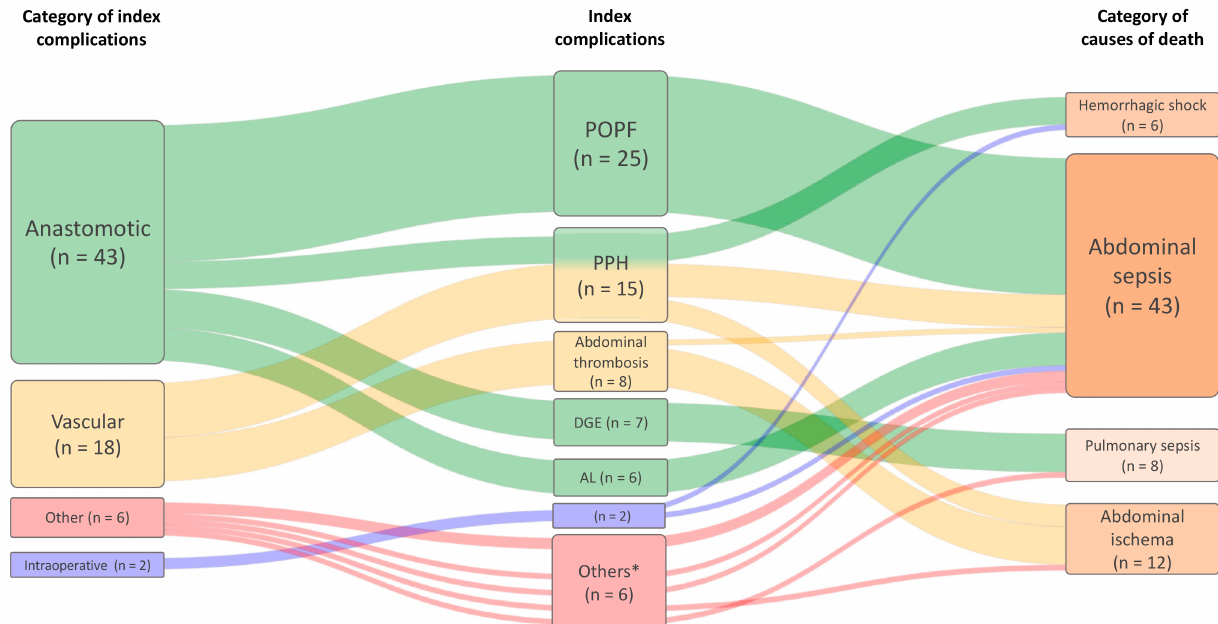
Figure 2. Sankey diagram illustrating the contribution of surgical index complications to causes of death; POPF = post- operative pancreatic fistula, PPH = post-pancreatectomy hemorrhage, DGE = delayed gastric emptying with aspiration, AL = anastomotic leakage (except pancreatic anastomosis), * includes = post-operative pancreatitis ( n = 2), non-occlusive mesenteric ischemia ( n = 1), disseminated intravascular coagulopathy ( n = 1), ileus ( n = 1), aspiration ( n =